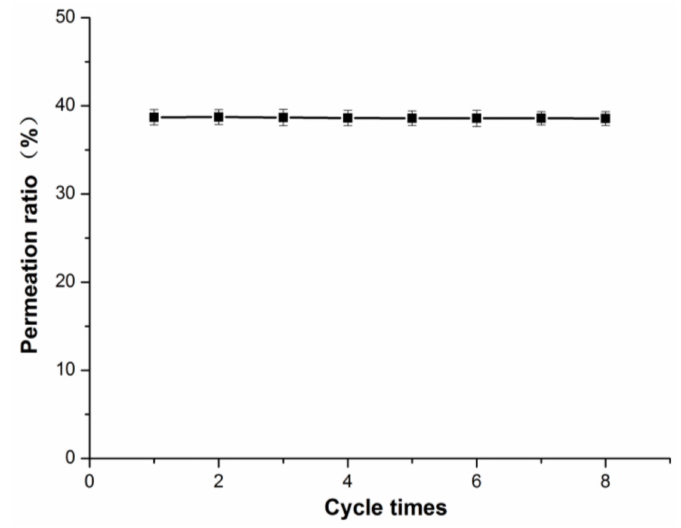
Figure 13. Reproducibility of